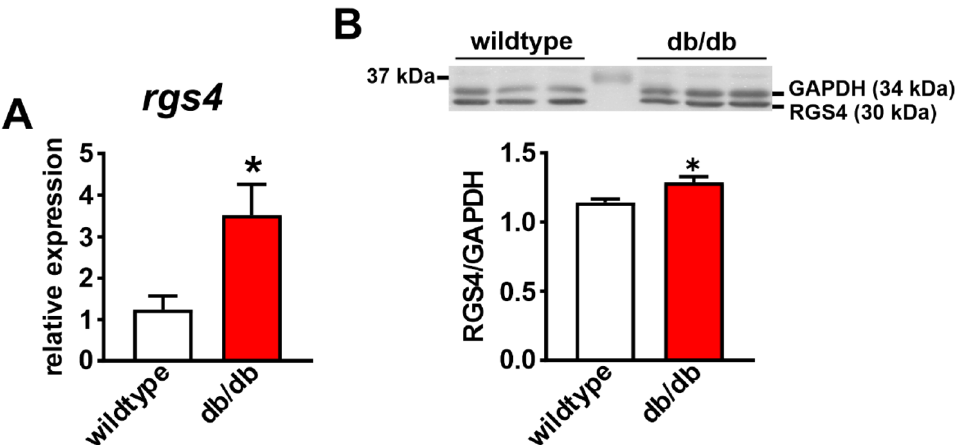
Figure 7. RGS4 gene and protein expression in the SAN in db/db mice. ( A ) mRNA expression of rgs4 in wildtype ( n = 5) and db/db ( n = 5) SAN. * P < 0.05 vs wildtype by Student’s t -test. ( B ) Representative Western blot and summary protein expression for RGS4 in the SAN of wildtype ( n = 6) and db/db ( n = 6) mice. * P < 0.05 vs. wildtype by Student’s t -test. Uncropped Western blot provided in Supplementary Fig.